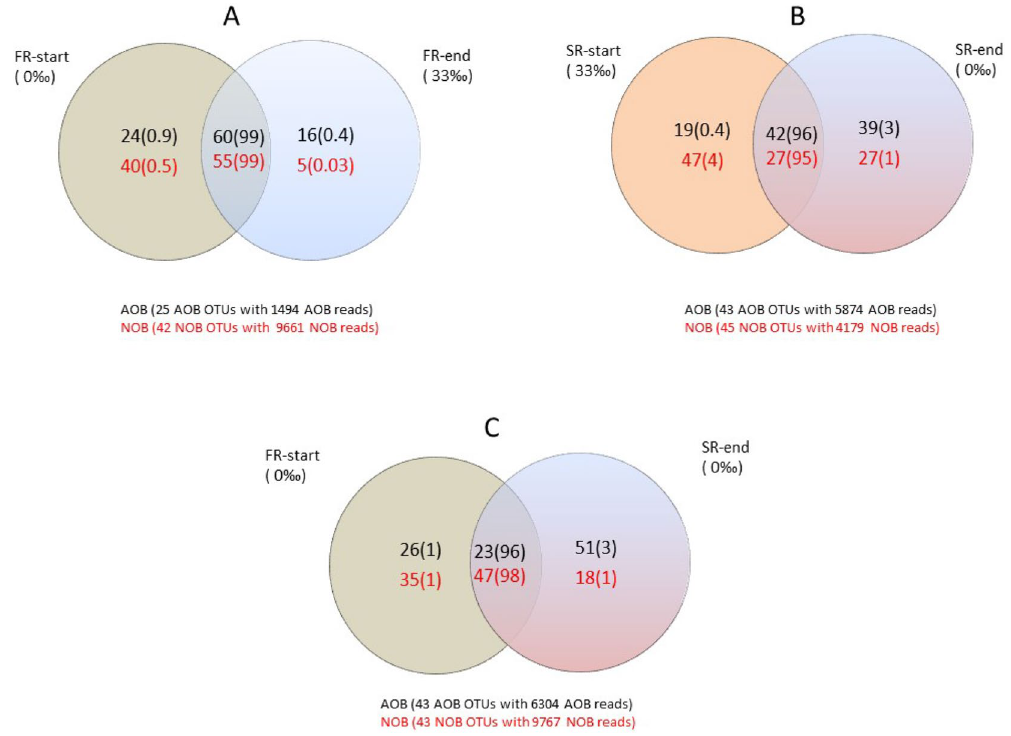
Figure 6. Venn diagrams in percentages showing the number of unique and shared OTUs, representing nitrifying bacteria for FR-start versus FR-end of freshwater reactor ( A ), SR-start versus SR-end of seawater reactor ( B ), at freshwater environment : FR-start vs SR-end ( C ). The numbers in black and red colour in each group indicate the number of unique or shared OTUs for the AOB and NOB guilds, respectively. The value in parenthesis shows the percentage of these OTUs represent of the total AOB or NOB sequences reads (e.g. for the Panel ( A ): 24 unique AOBs constitute 0.9% of the total 1494 AOB reads). Numbers in overlapping regions indicate number of shared